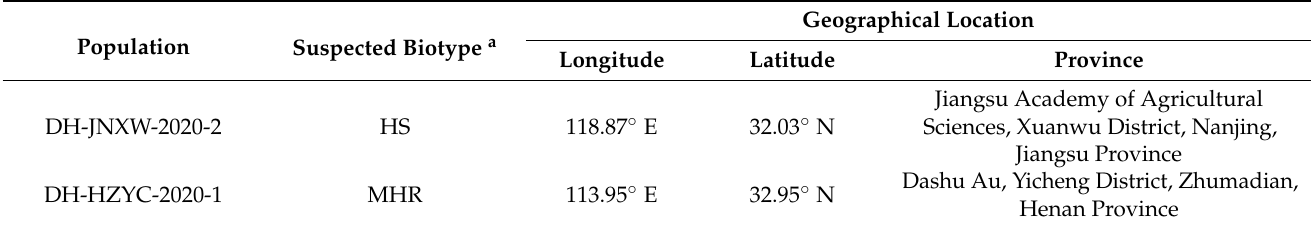
Table 1. Geographical information for the two L. multiflorum populations used in this study.